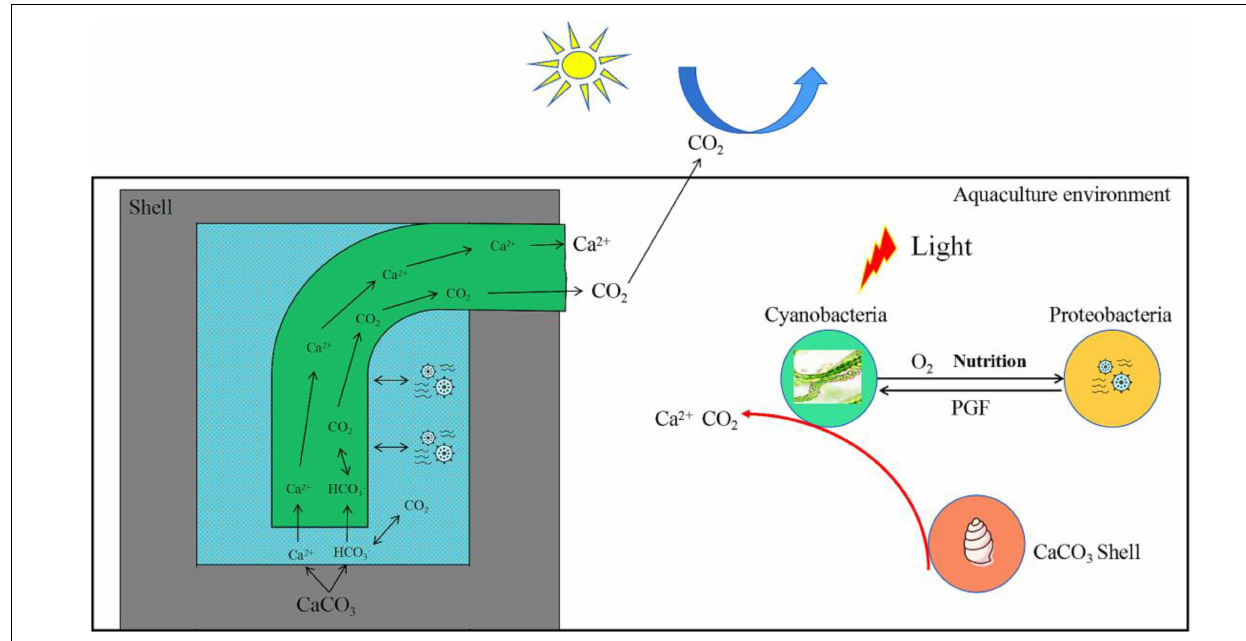
FIGURE 10 | Model diagram of interaction between Cyanobacteria and Proteobacteria to promote the bioerosion of snail shells. PGF, promote growth factors.